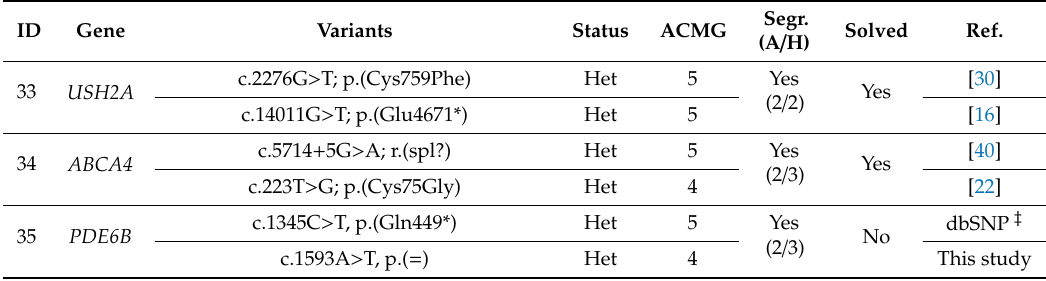
Table 2. Likely pathogenic mutations detected in IRD genes by clinical exome sequencing.